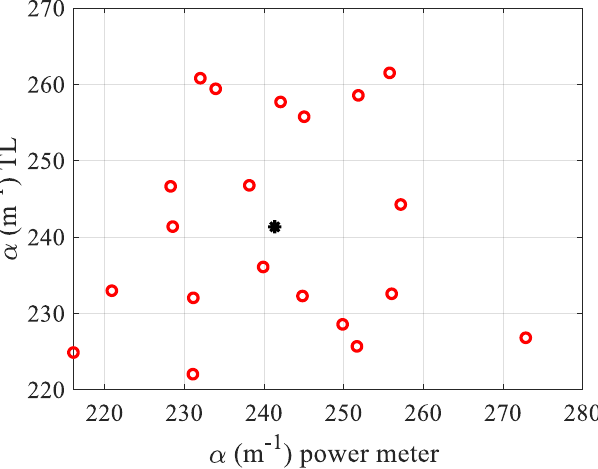
Figure 3. Calibration of the optical setup. The measured absorption through thermal lens process is made equal to the 𝛼 measured by the OPM through a calibration factor. Empty circles (red): experimental data; star (black): mean value.